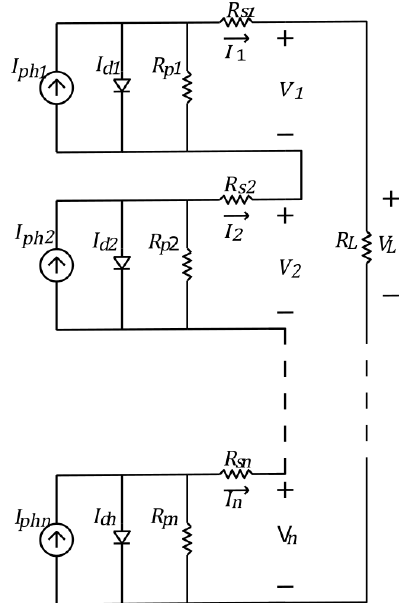
Figure 3. Multy array diode model circuit.